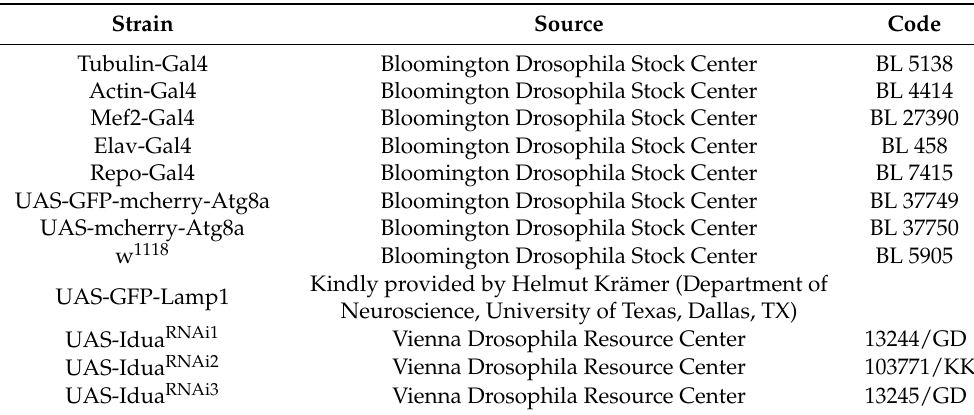
Table 1. Drosophila strains used in the project’s